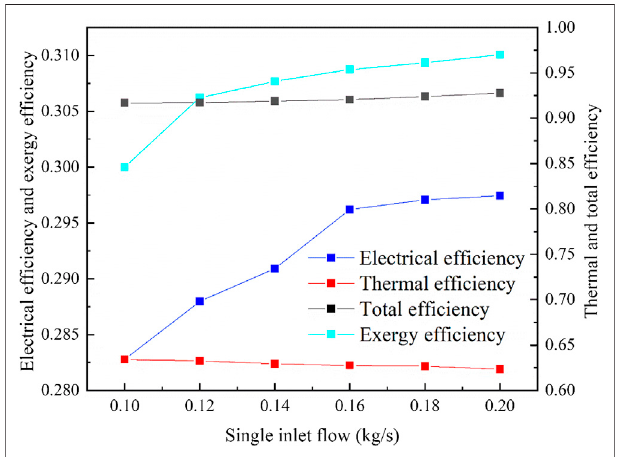
FIGURE 12 | Inlet temperature of cooling water on the thermal exergy ef fi ciencyandexergyef fi ciencyofthecellunderthefour-jet nozzlesinsummer and